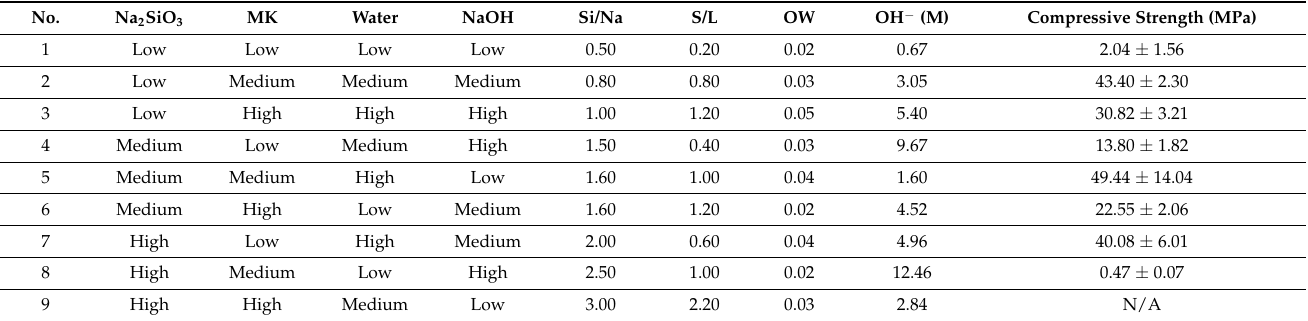
Table 1. Mix proportions and compressive strength of the experimental design for studied factors. (The designed mix proportions according to the L 9 3 4 orthogonal arrays.)